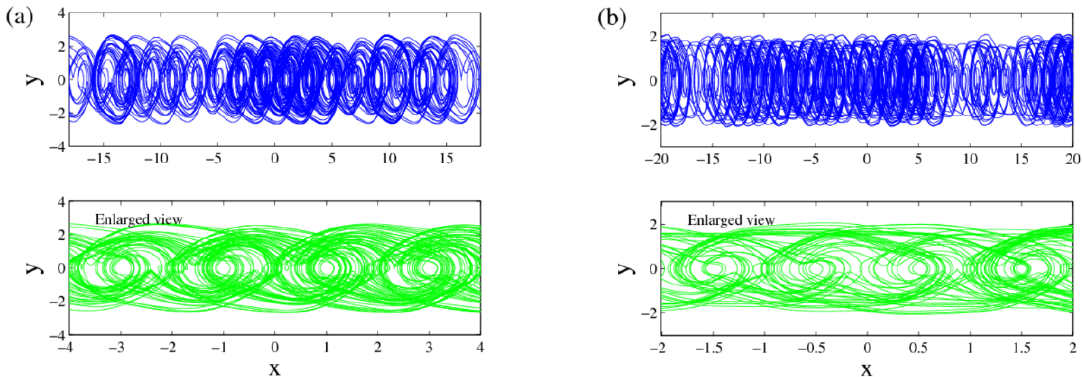
Figure 4. Multi-scroll chaotic attractors with ( a ) d = π and ( b ) d = 2 π .